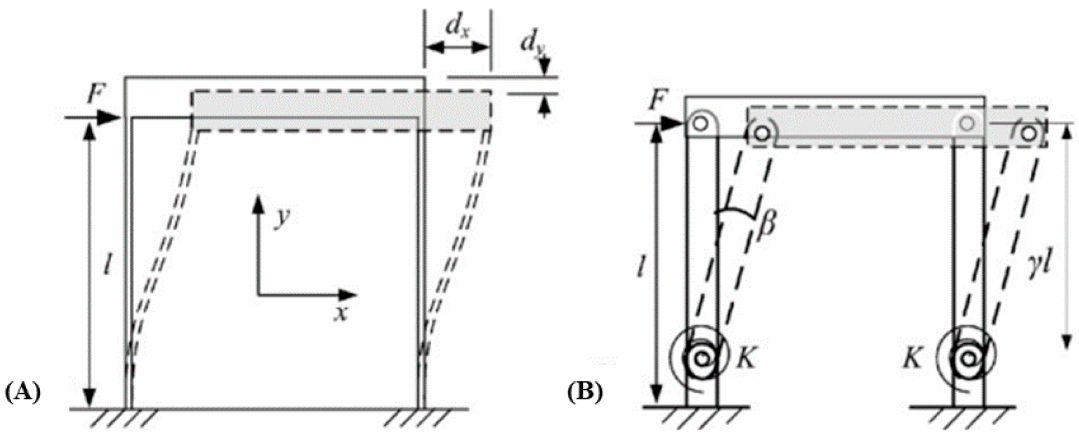
Figure 13. ( A )A parallel CM. ( B ) Its PRBM equivalent [101] with its l converted to its characteristic equivalent, γ l and its flexing elements reinterpreted as torsional spring of characteristic stiffness K . Both γ and K are dependent on the loading subjected on